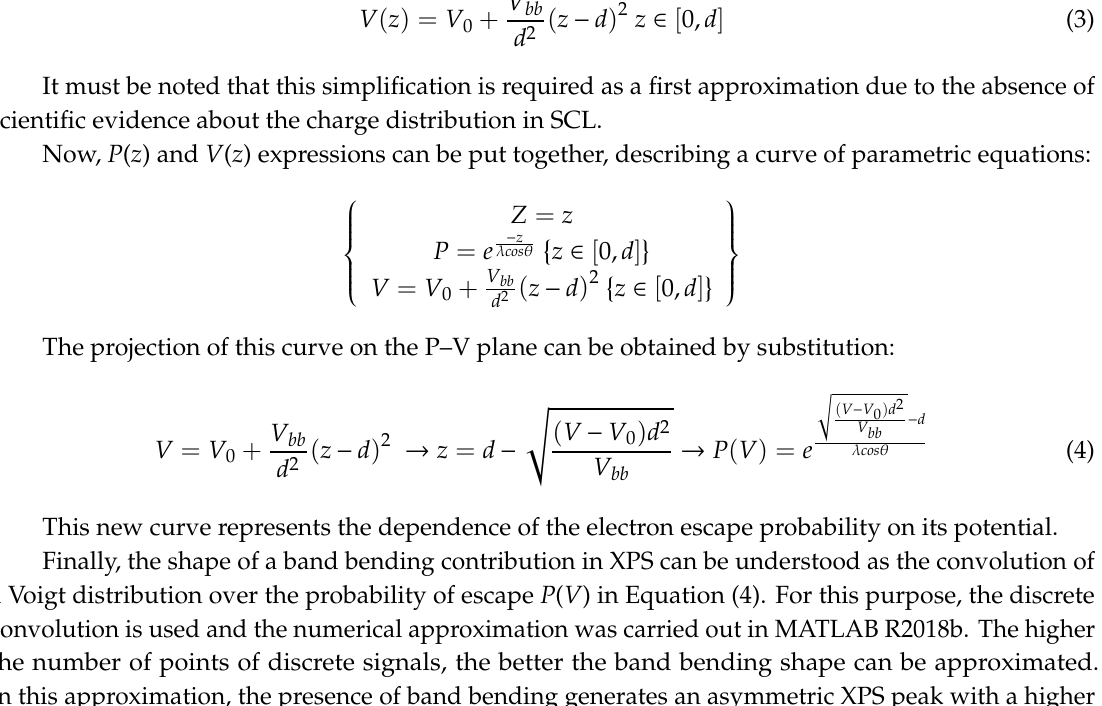
Figure 3. By using λ , it is possible to calculate the escape probability P ( z ) curve for selected polar angles θ = 0 ◦ , 45 ◦ , 70 ◦ , and 80 ◦ (see Equation (1)) and, thus, the sensitivity depth can be estimated. Since P ( z ) P ( z ) < 99%, that is 11.05, 7.81, 3.78, and 1.91 nm for θ = 0 ◦ , 45 ◦ , 70 ◦ , and 80 ◦ , respectively.